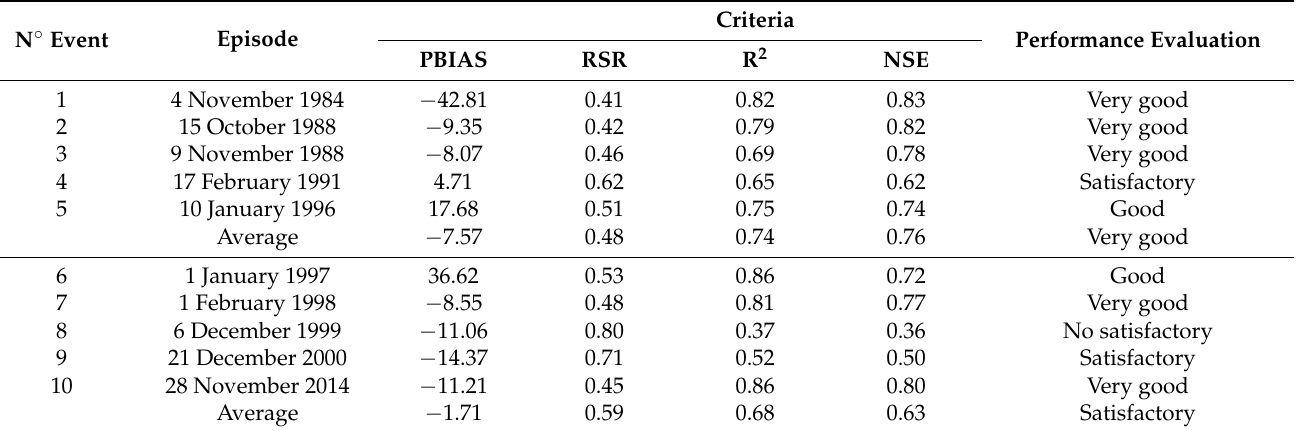
Table 6. Statistical analysis of calibration and validation events by calculating some performance